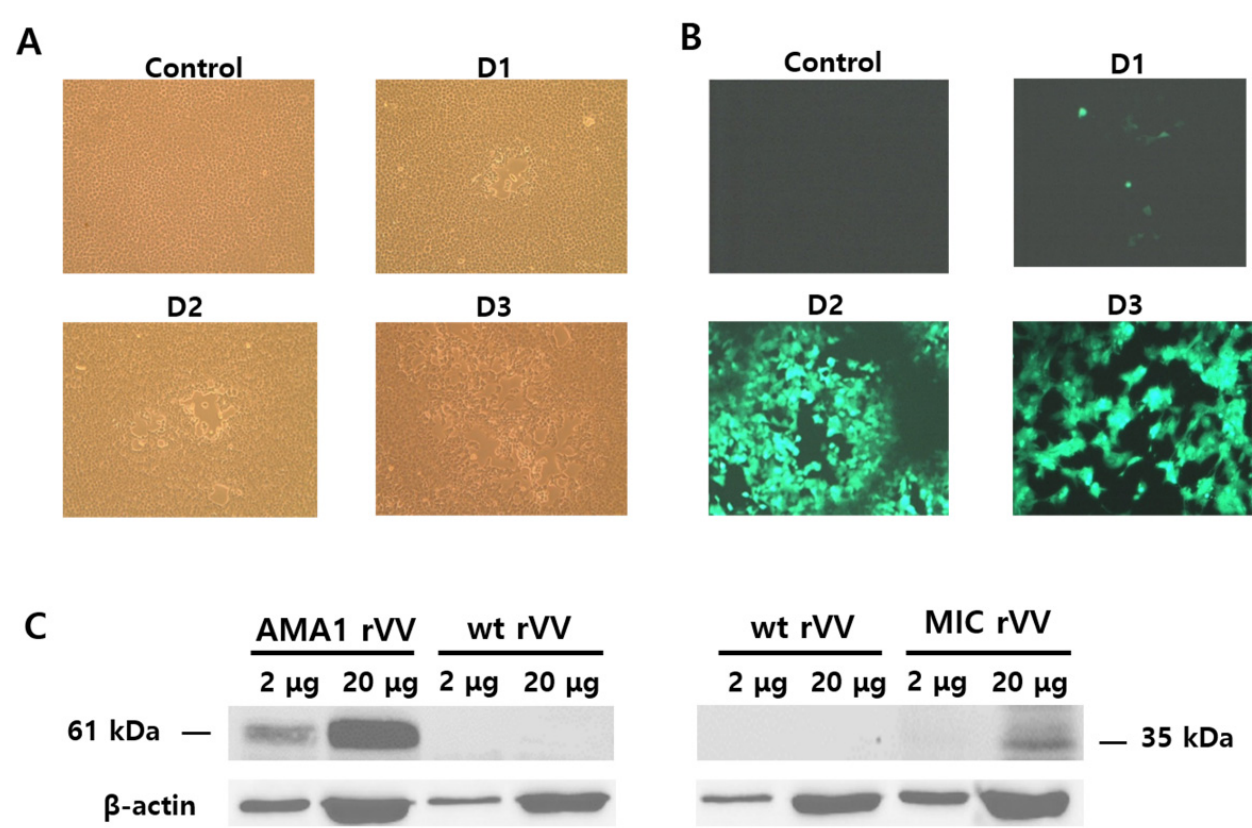
Figure 1. Gene cloning. To generate P. berghei AMA1 and MIC recombinant vaccinia virus (rVV), gene cassettes with promoters and recombination sites were designed, shown as a schematic diagram ( A , B ). PbAMA1 or PbMIC genes were cloned into the pRB21 vector, and clones pRB21- AMA1 ( C ) and pRB21-MIC ( D ) were confirmed by restrictive enzyme digestion with EcoR Ⅰ and Hind Ⅲ . The red color font denotes successful clones.